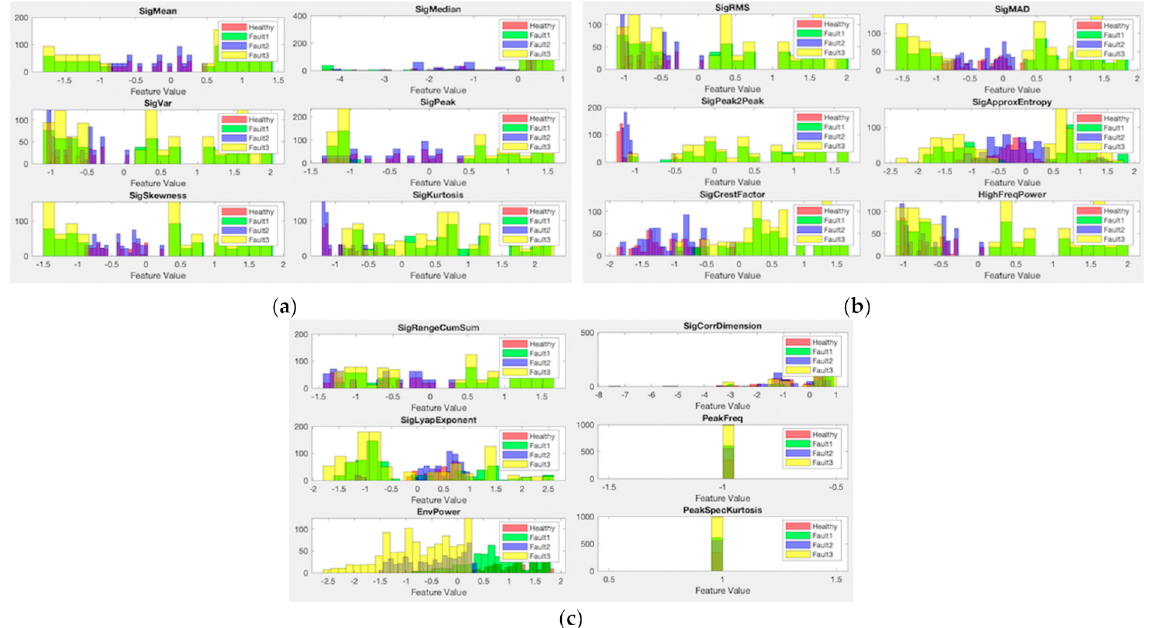
Figure 11. Features vs. classes graphs for the synthetic data with ensemble bagged tree algorithm: ( a ) Feature vs. classes graphs for mean, median, variance, peak value, skewness and kurtosis; ( b ) Feature vs. classes graphs for RMS value, MAD, peak-to-peak value, approximate entropy, crest factor and high-frequency power; ( c ) Feature vs. classes graphs for range of cumulative sum, correlation dimension, Lyapunov exponent, peak frequency, envelope power and spectral